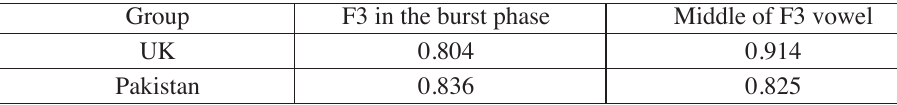
Consistency among the repetitions in F3 Group